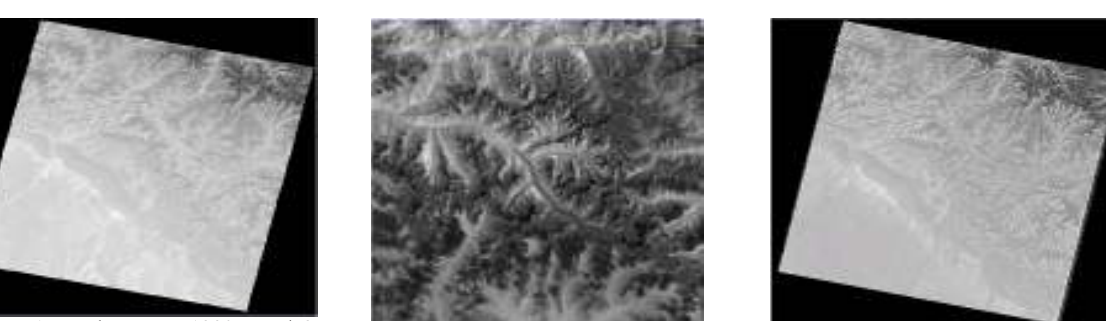
Figure 3. Landsat TM5, 2010 Band 6 image of study